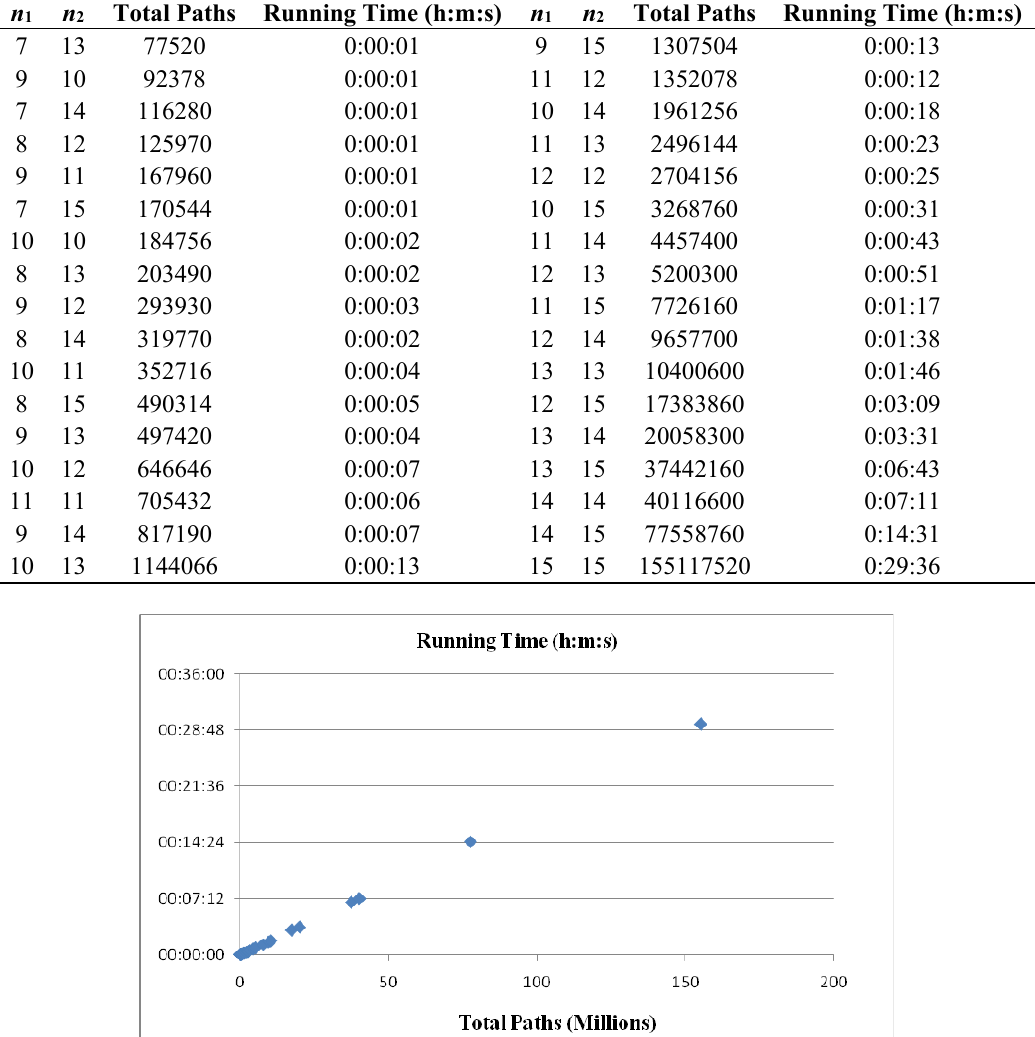
Table 3. Running Time of G2DLP vs. Total Paths.